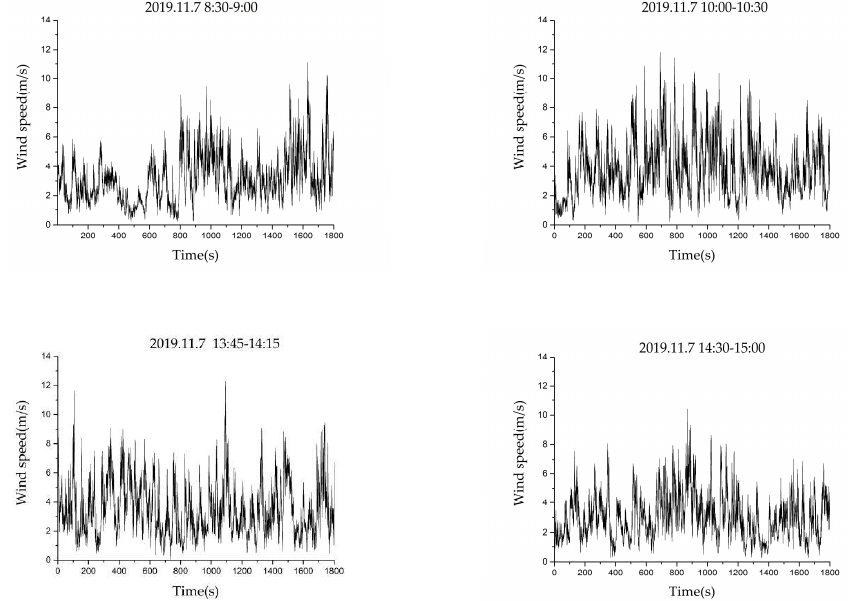
Figure 4. The time history curves of absolute values of wind speed in the first four monitoring pe- riods.